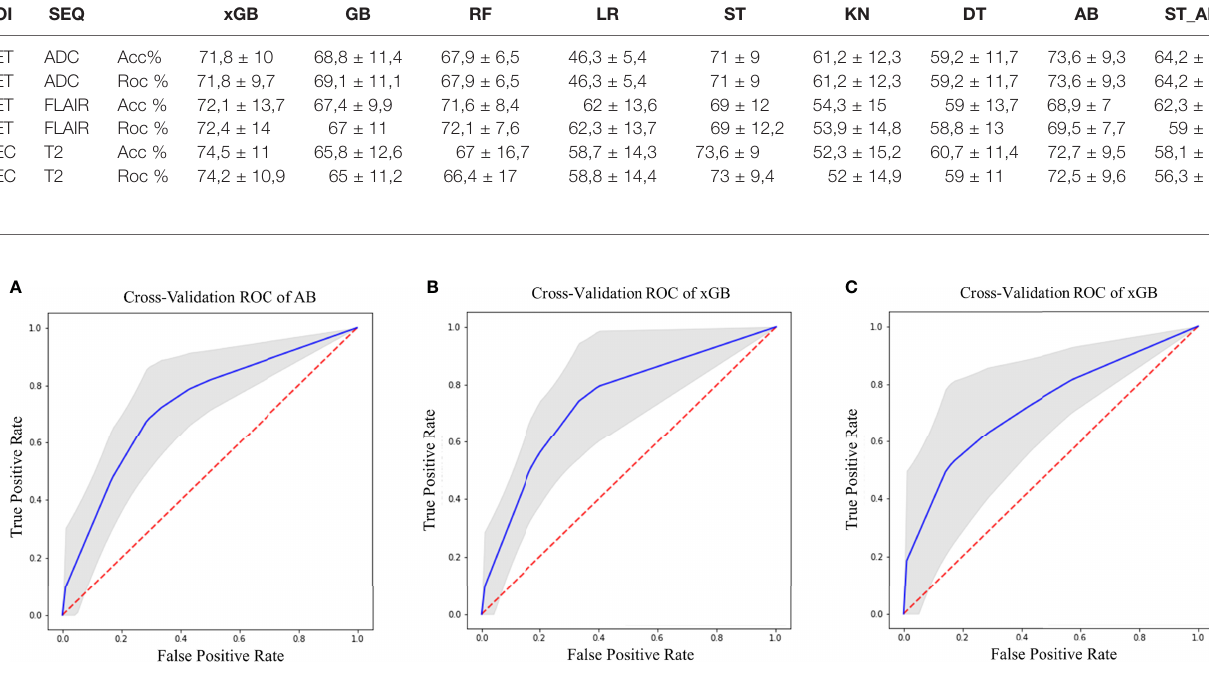
FIGURE 3 | Best ROC curves for Surv12 prediction: (A) AB classi fi er with ADC sequence on NET ROI; (B) xGB classi fi er with T2 sequence on NEC ROI; (C) xGB classi fi er with FLAIR sequence on NET ROI.